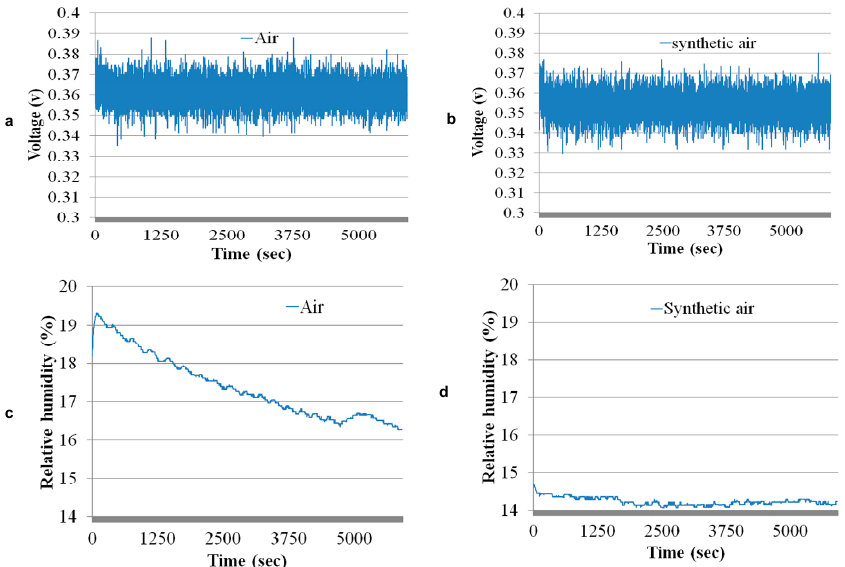
Figure 10. ( a ) Baseline of the electrochemical sensor with ambient air; ( b ) baseline of the electrochemical sensor with synthetic air; ( c ) baseline of the humidity sensor with air; ( d ) baseline of the humidity sensor with synthetic air.